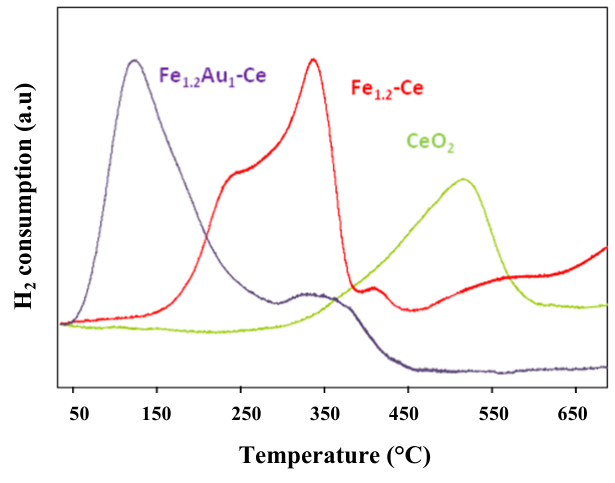
Figure 8. Comparison among H Fe Au -Ce 1.2 1